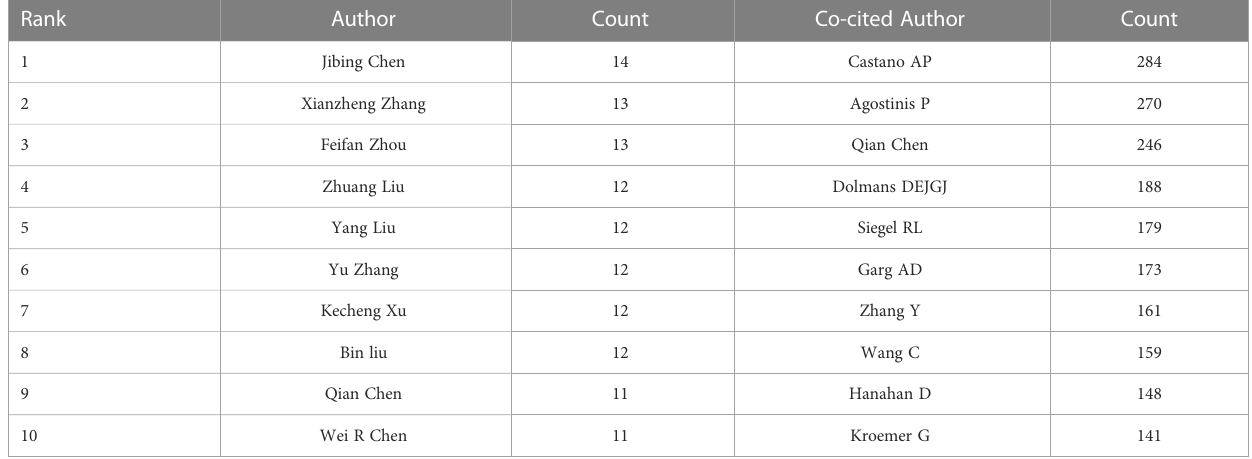
TABLE 1 The top 10 authors and co-cited authors involved in research on tumor ablation and immunity.